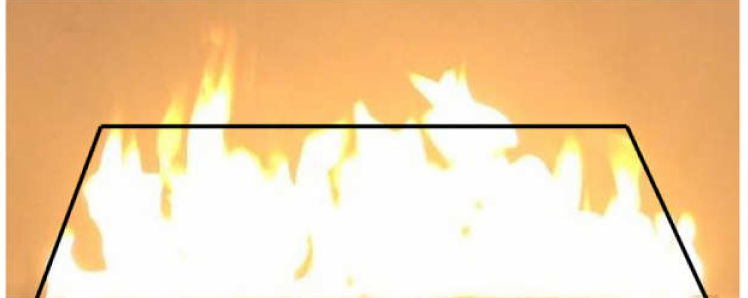
Figure 5. Front view of the flame.